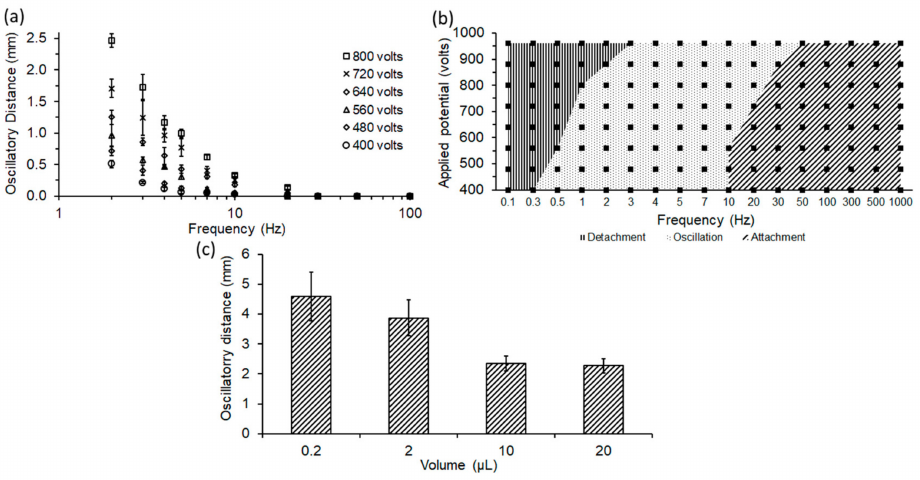
Figure 3. Characterization of water droplet (0.3 µ L) motion with the high voltage electrode of electrical tweezer (electrodes 4 mm apart): ( a ) Maximum oscillatory distance of water droplet with the high-voltage electrode for tested range of frequencies (2–100 Hz) and for applied maximum sinusoidal electric potential (400–800 V); ( b ) electrical parameters to select the type of droplet motion with a high-voltage electrode under the tested range of frequencies (0.1–1000 Hz) and applied maximum sinusoidal electric potential (400–960 V); ( c ) dependence of oscillatory distance of water droplet with the high-voltage electrode for various droplet volumes (0.2, 2, 10, 20 µ L), under the electric potential of 640 V (V/d = 160 V/mm) at 2